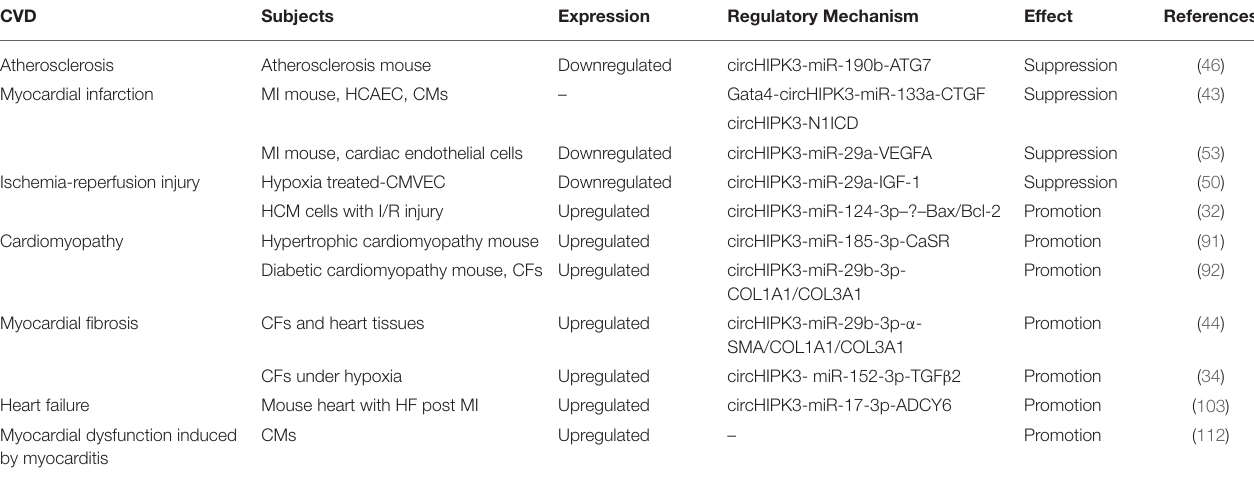
TABLE 1 | The mechanisms of circHIPK3 in